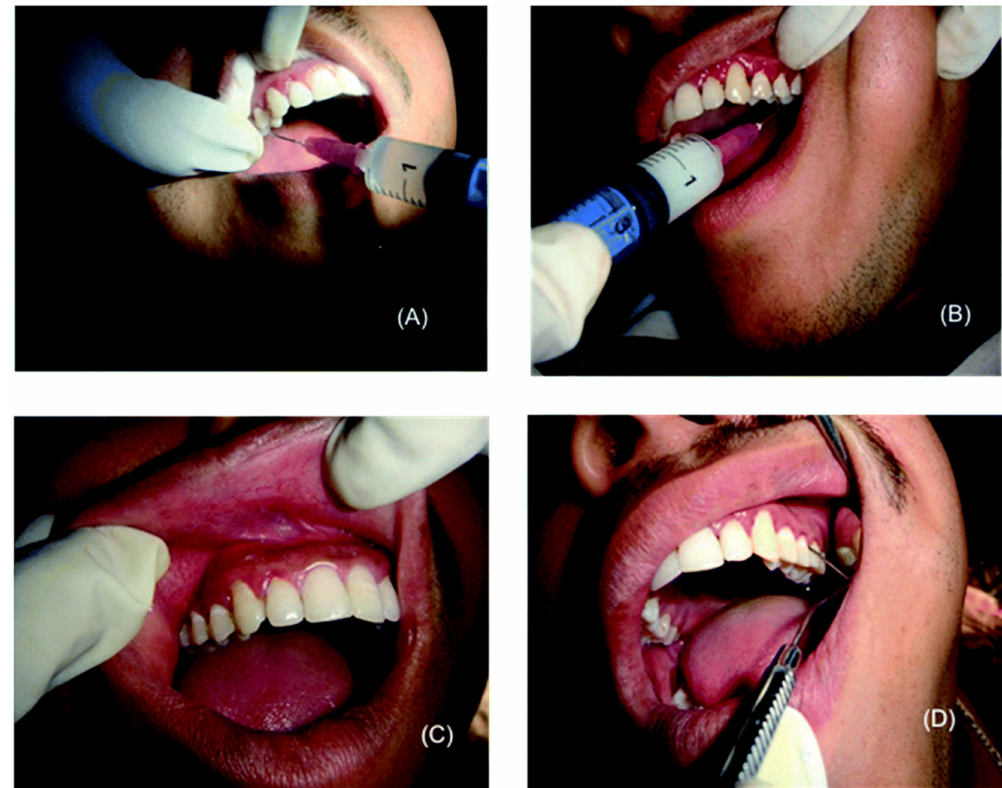
Figure 10. Snapshots of a patient undergoing a clinical study detailed in Singh et al. The trial was split mouth, i.e., locations for groups designated as A and B were both situated in the mouth of the same person. ( A ) Gel containing conventional SZ and ( B ) SCMC gel bearing G-PNPs loaded with SZ being administered on the 0th day; ( C ) and ( D ) show level of healing on the 21 st day in groups A and B, respectively. The indentations have filled up, with no evidence of bleeding on probing. Reproduced with permission from Singh et al.